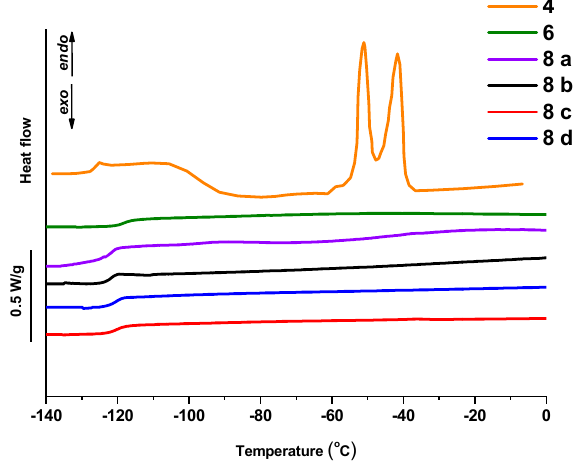
Figure 10. DSC curves for polymers 4 , 6 , and 8 a – d at a heating rate of 10 °C/min.